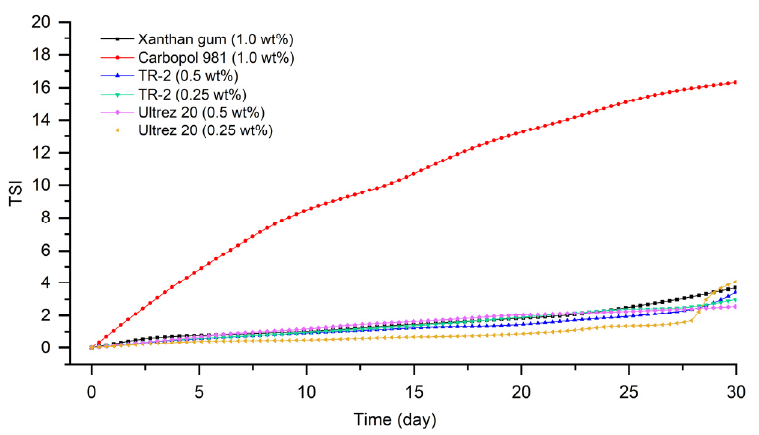
Figure 5. TSI values of emulsions stored at 45 °C for a